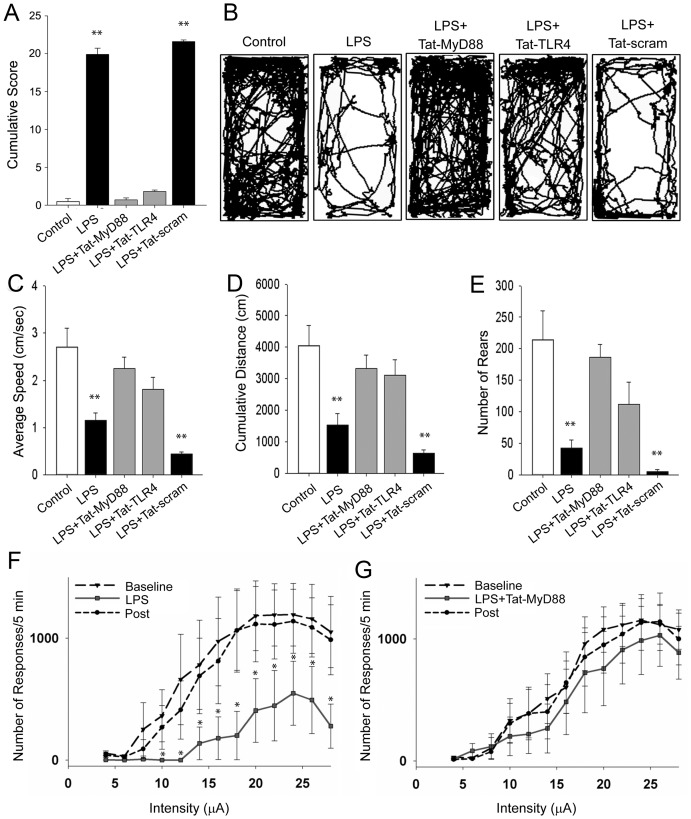
LPS induced sickness behavior was blocked by Tat-MyD88 and Tat-TLR4 as assessed in mice using a modified SHIRPA screen and in the novel home cage following various treatments.A. Cumulative score of sickness obtained using the SHIRPA screen. B. Representative paths of mice over 30 min in the home cage showing decreased exploration induced by LPS, and effective block by Tat-MyD88 and Tat-TLR4 but not Tat-scram. Average speed travelled (C), cumulative distance travelled (D), number of rears in the home cage (E). F, G. Assessment of sickness behavior in rats using intracranial self stimulation. F. Number of responses per minute during baseline, LPS treatment, and following LPS treatment. G. Number of responses per minute during baseline, LPS plus Tat-MyD88 treatment, and following LPS plus Tat-MyD88.